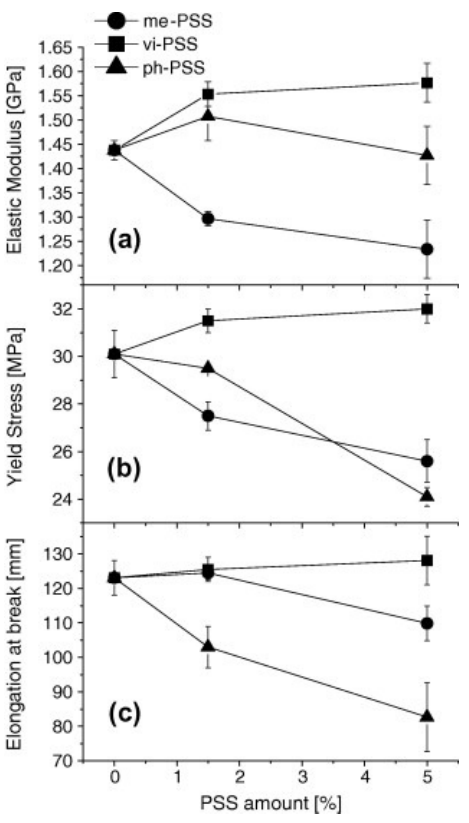
Figure 6. Influence of ( ● ) methyl-POSS (me-PSS), ( ▲ ) phenyl-POSS (ph-PSS) and ( ■ ) vinyl-POSS (vi-PSS) on (top) Young’s modulus, (middle) yield stress and (bottom) elongation at break of polypropylene. Values of mechanical properties were obtained